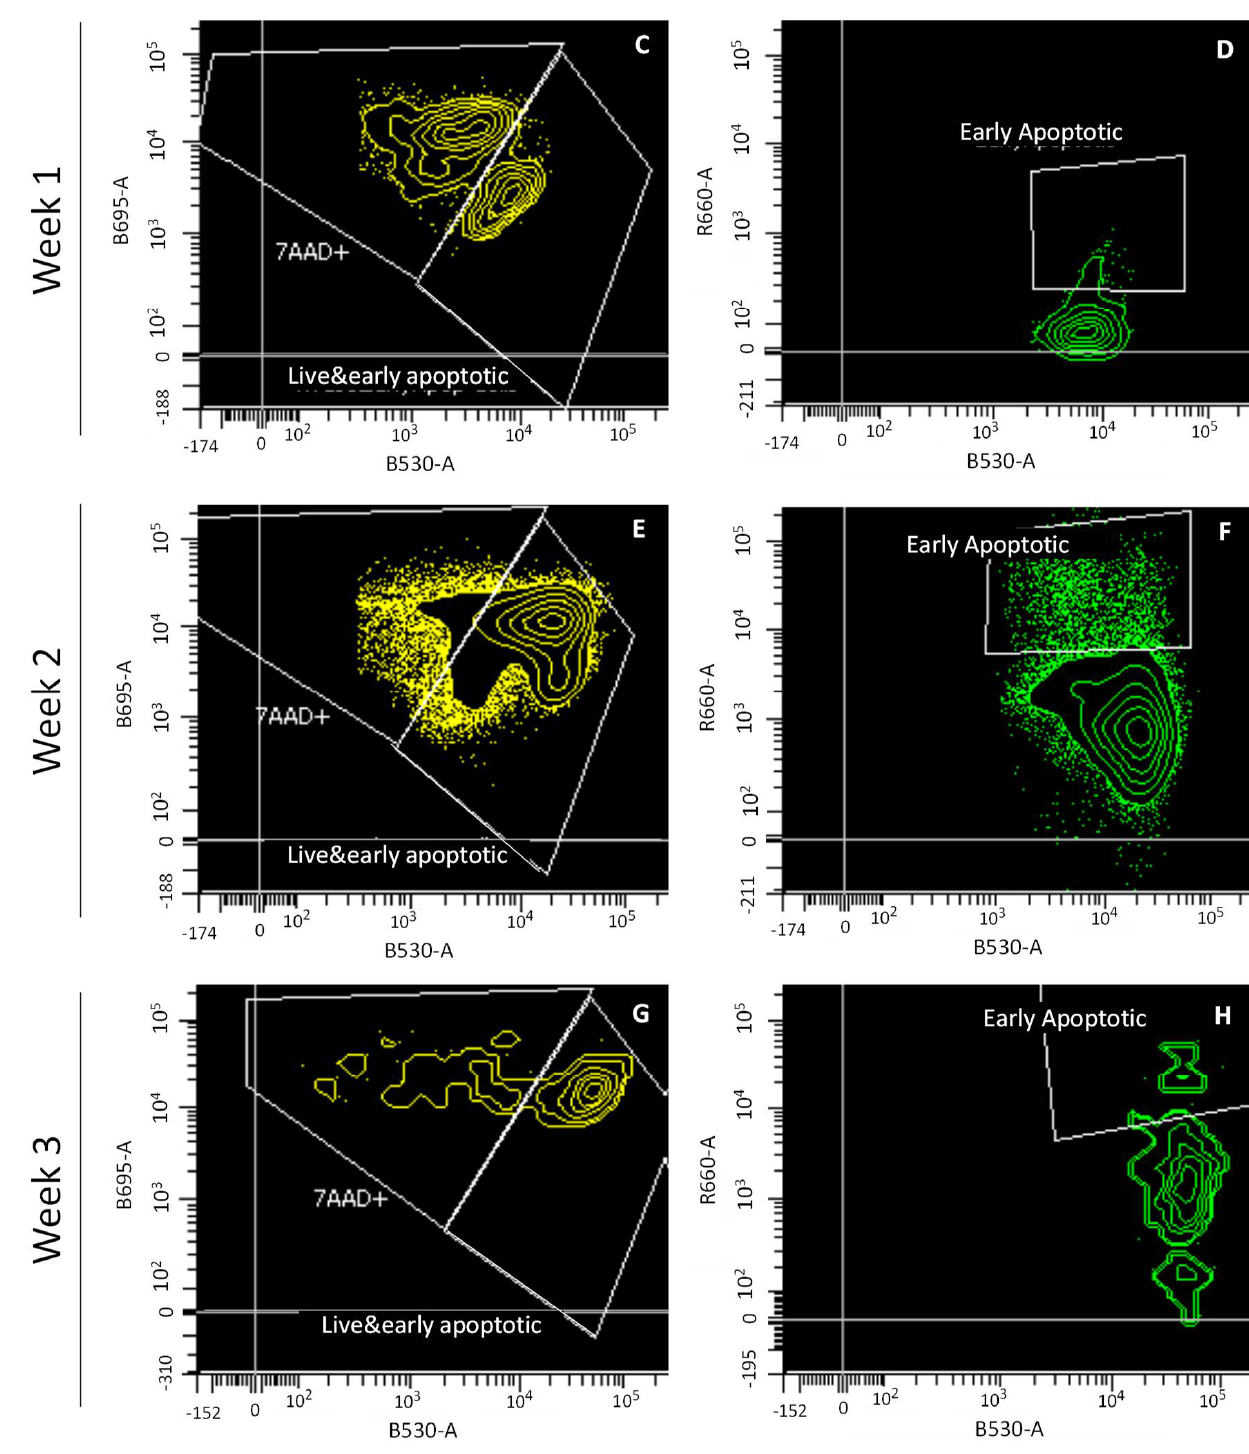
Figure 3. Flow cytometry analysis of cell viability of cartilage preserved at day 0, and at weeks 1, 2 and 3. Channels shown: calcein (B530-A), 7-AAD (B695-A) and Annexin V (R660-A). Plots shown: day 0 ( A , B ), week 1 ( C , D ), week 2 ( E , F ), and week 3 ( G , H